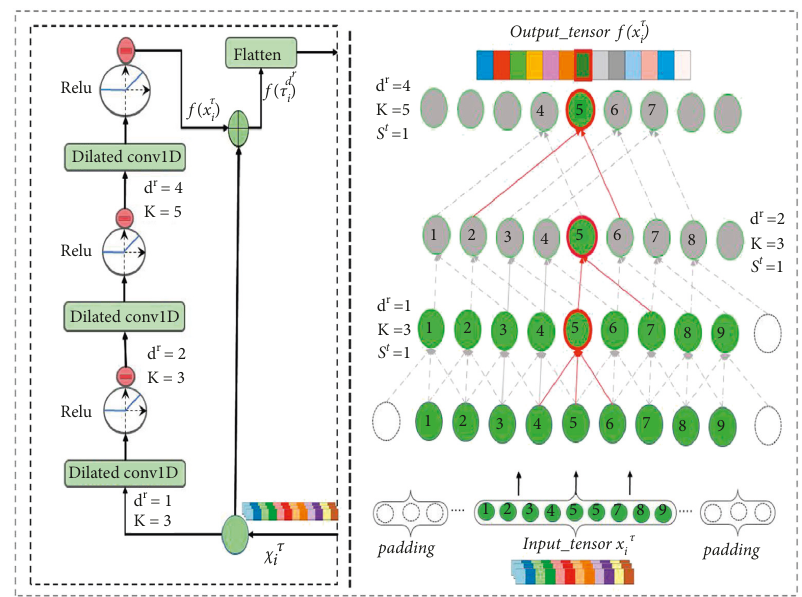
Figure 6: An illustration of our proposed residual dilated convolutional module (RDCM). On the left side of the figure, we show the RDCM module’s architecture. The right side represents the dilation convolutional operations by expansion of the receptive field (dilation parameter) and different sizes of kernels (K) to obtain optimal feature